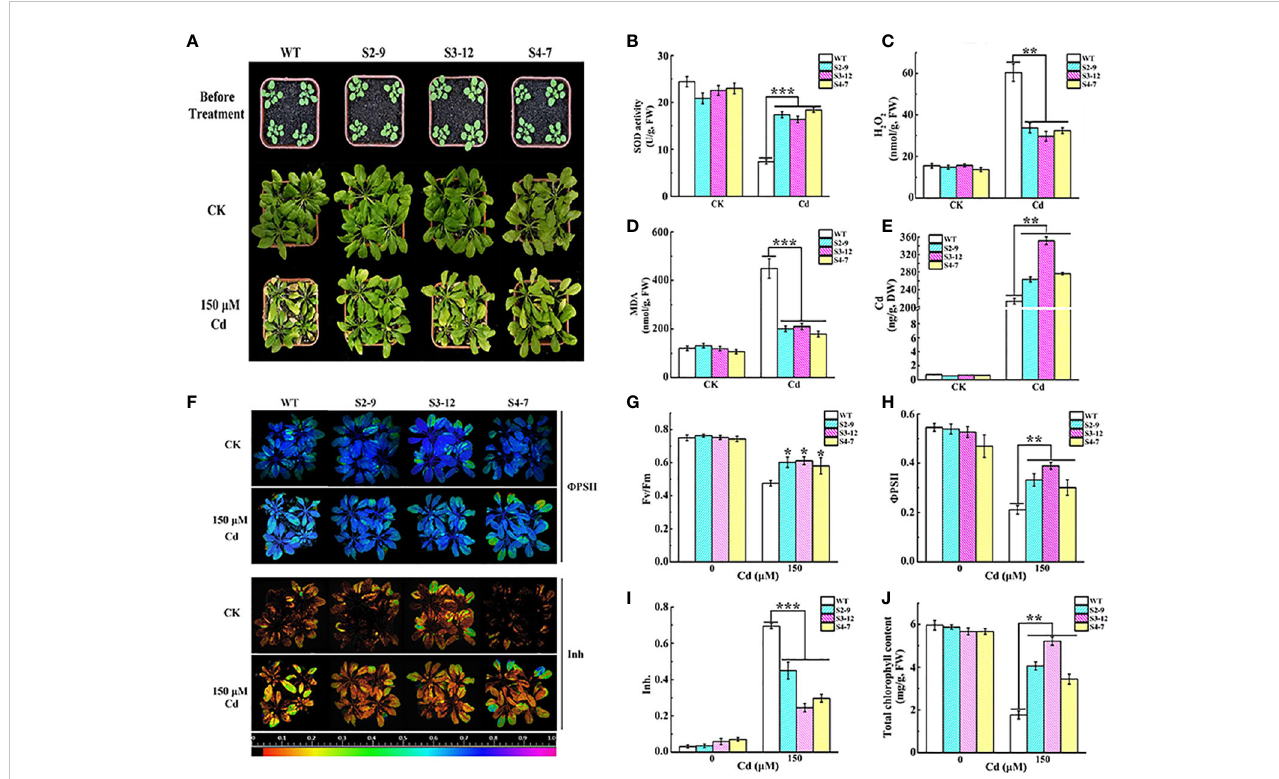
FIGURE 3 Overexpression of TaSBP-A alleviated the oxidative stress and photosynthesis impairment triggered by Cd treatment in Arabidopsis. (A) Phenotypic comparison of the wild type and transgenic Arabidopsis lines (S2-9, S3-12, and S4-7) under Cd stress. Three-week-old plants were watered with 150 m M CdCl 2 once a week for four weeks. Control group (CK) was normally irrigated with water. (B – D) Changes of SOD activity, H 2 O 2 and the MDA content of transgenic Arabidopsis and the wild type (WT). (E) The Cd content changes in the roots of transgenic and wild type lines. (F) Chlorophyll fl uorescence changes of the ef fi ciency of PSII in the light ( F PSII), and the inhibition of the PSII quantum yield (Inh.) of WT and overexpressed Arabidopsis lines. (G – I) Changes of chlorophyll fl uorescence parameters F v /F m (G) , F PSII (H) , and Inh (I) extracted from fl uorescence images. (J) Chlorophyll content changes of WT and the transgenic line under Cd stress. The data are indicated as mean± SD from three biological replicates. All data were statistically analyzed using a one-way ANOVA. The asterisks represent signi fi cant differences at different levels (* p < 0.05; ** p < 0.01; *** p <